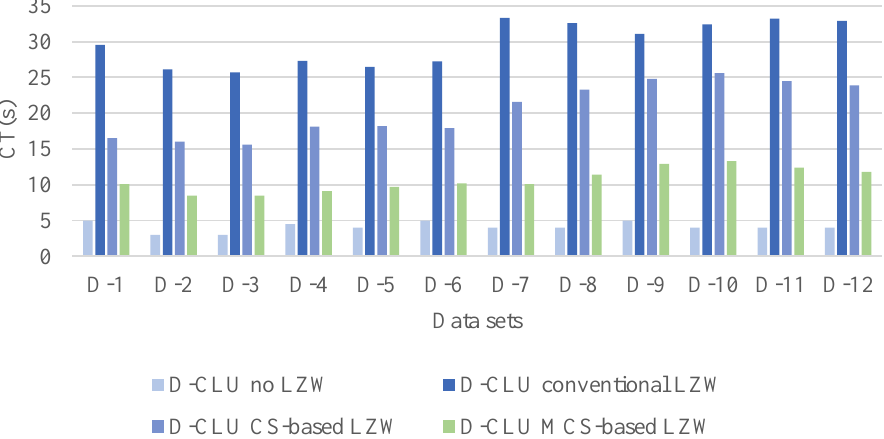
Figure 8. CTs of the D-CLU algorithm by using LZW compression and without using LZW com- pression.